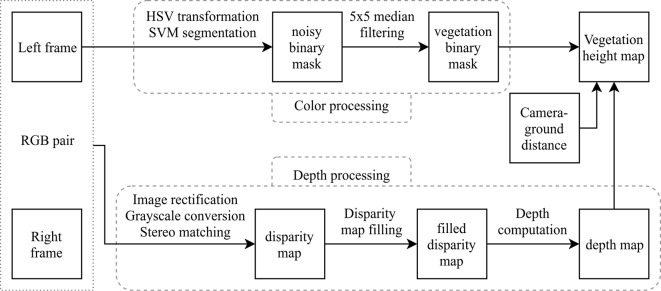
Processing pipeline.